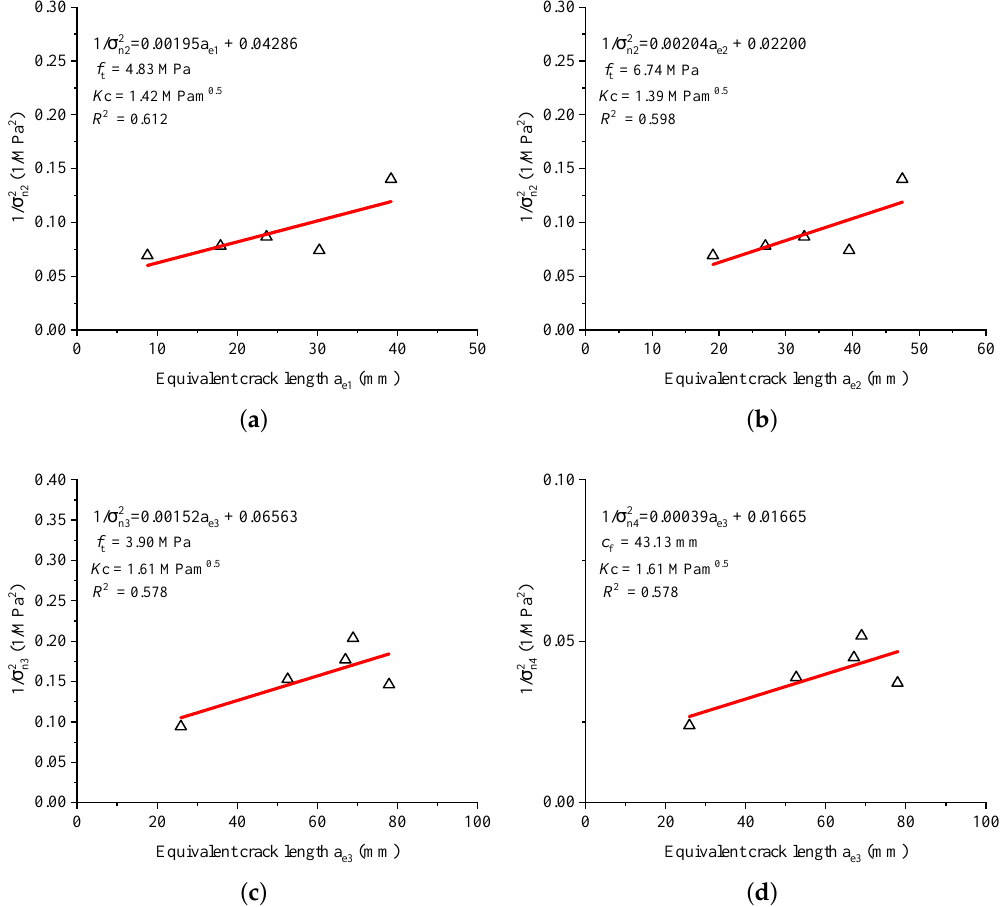
Figure 8. Test results in [32,33] and the corresponding fitted curves of ( a ) Hu-Guan’s boundary effect model with β 1 = 1, ( b ) modified Hu-Guan’s boundary effect model with β 1 = 1, ( c ) Koval-Gao’s size and boundary effect model and ( d ) Bažant’s Type 2 size effect